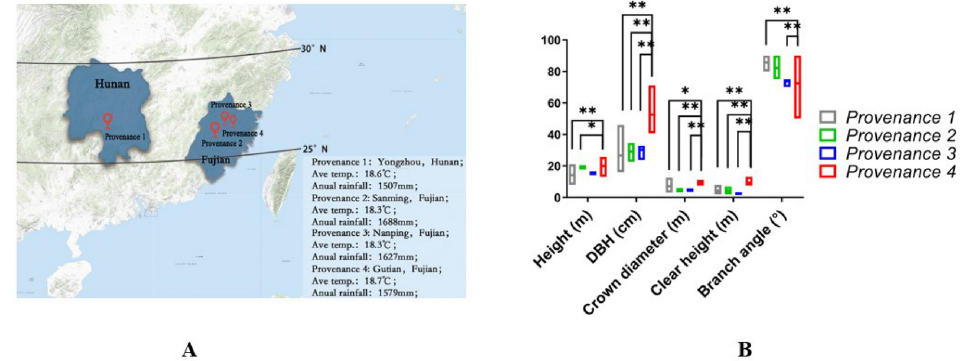
Fig 1. Geographical distribution and phenotypic differences among F . hodginsii from four provenances. ( A ) The geographical distribution of the four provenances, almost at the same latitude. Provenance 1 is from Yongzhou, Hunan (average temperature 18.6˚C, annual rainfall 1507 mm); provenance 2 is from Sanming, Fujian (average temperature 18.3˚C, annual rainfall 1688 mm); provenance 3 is from Nanping, Fujian (average temperature 18.3˚C, annual rainfall 1627 mm); provenance 4 is from Gutian, Fujian (average temperature 18.3˚C, annual rainfall 1579 mm). This picture is from USGS National Map Viewer (https://apps.nationalmap.gov/viewer/). ( B ) The phenotypic characteristics of the four provenances were statistically analyzed based on height (m), diameter at breast height (cm), crown diameter (m), clear height (m), and branch angle (˚). Height is measured as the distance from the root on the ground to the top of the tree. DBH measures the diameter of a tree 1.3-m above the ground. Crown diameter is the arithmetic mean of the maximum and minimum numbers. Clear height calculates the height of the trunk. Branch angle represents the angle of the outermost branch of the crown. Data for each index were collected from 15 samples. � and �� indicate significant differences ( P < 0.05 and P < 0.01, respectively) relative to P4 in height, diameter at breast height, crown diameter, clear height, and branch angle, based on one-way ANOVA with multiple comparisons using